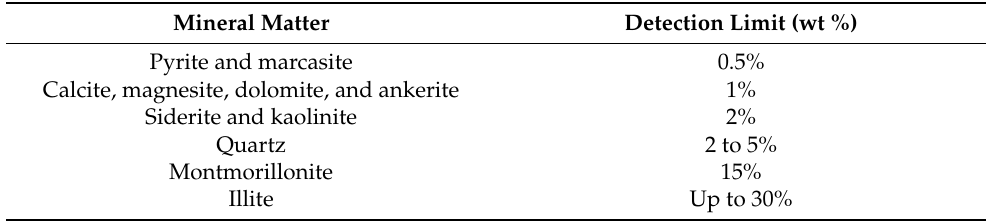
Table 4. Detection limits of minerals in an inert nitrogen (N2) atmosphere by DTA [199,202]. Mineral